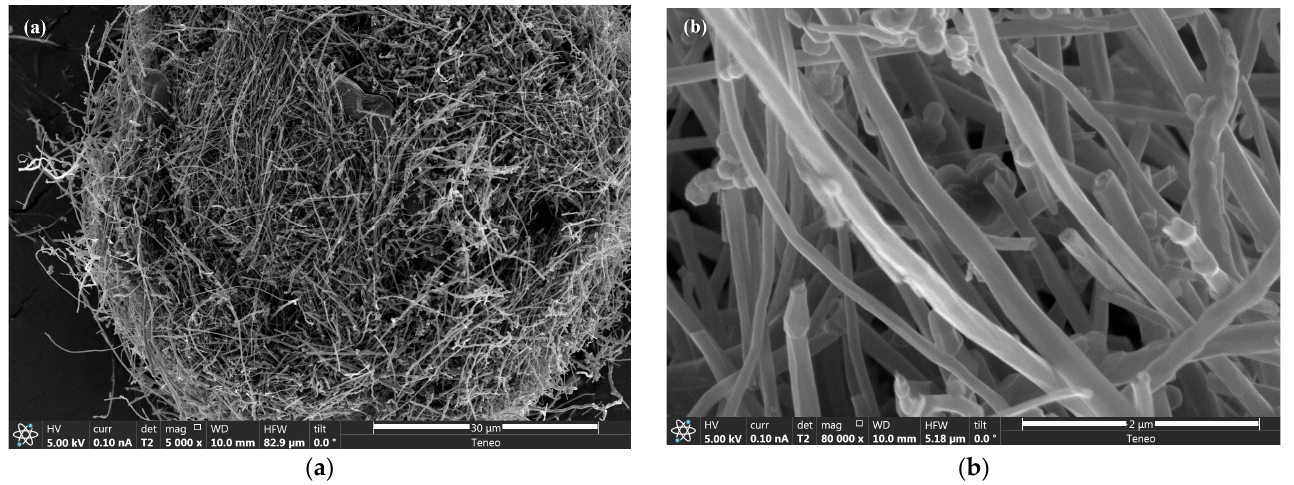
Figure 2. ( a ) Low- and ( b ) high-magnification SEM image of electrospun carbon nanofibers.